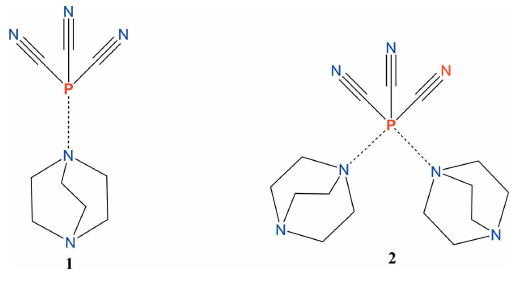
(cid:4) z , 2 (cid:4) y , 1 (cid:4) z 2